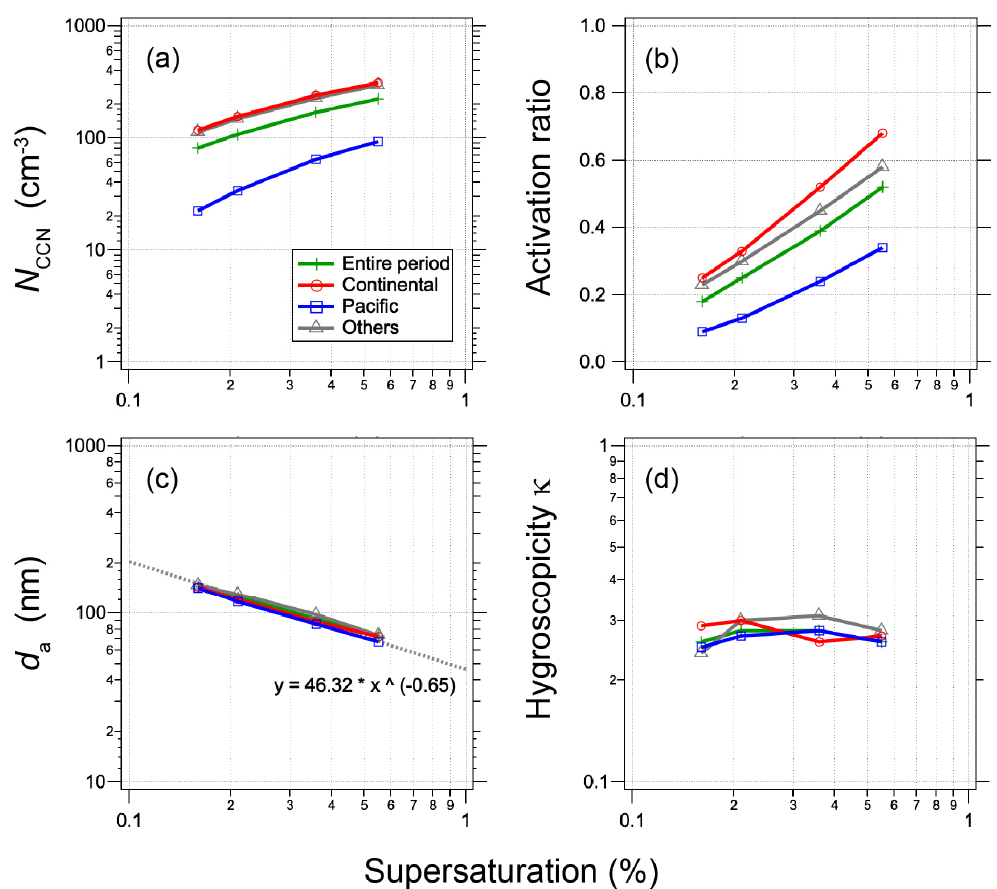
Figure 5. Relationship between water vapor supersaturation (%) and the median values of ( a ) number concentration of CCN ( N CCN ) ( b ) activation ratio ( N CCN / N CN ) ( c ) activation diameter ( d a ) and ( d ) hygroscopicity parameter ( κ ), classified according to air mass origins. Green, red, blue, and gray lines and markers represent the entire period, Continental, Pacific, and Others airmass periods, respectively.